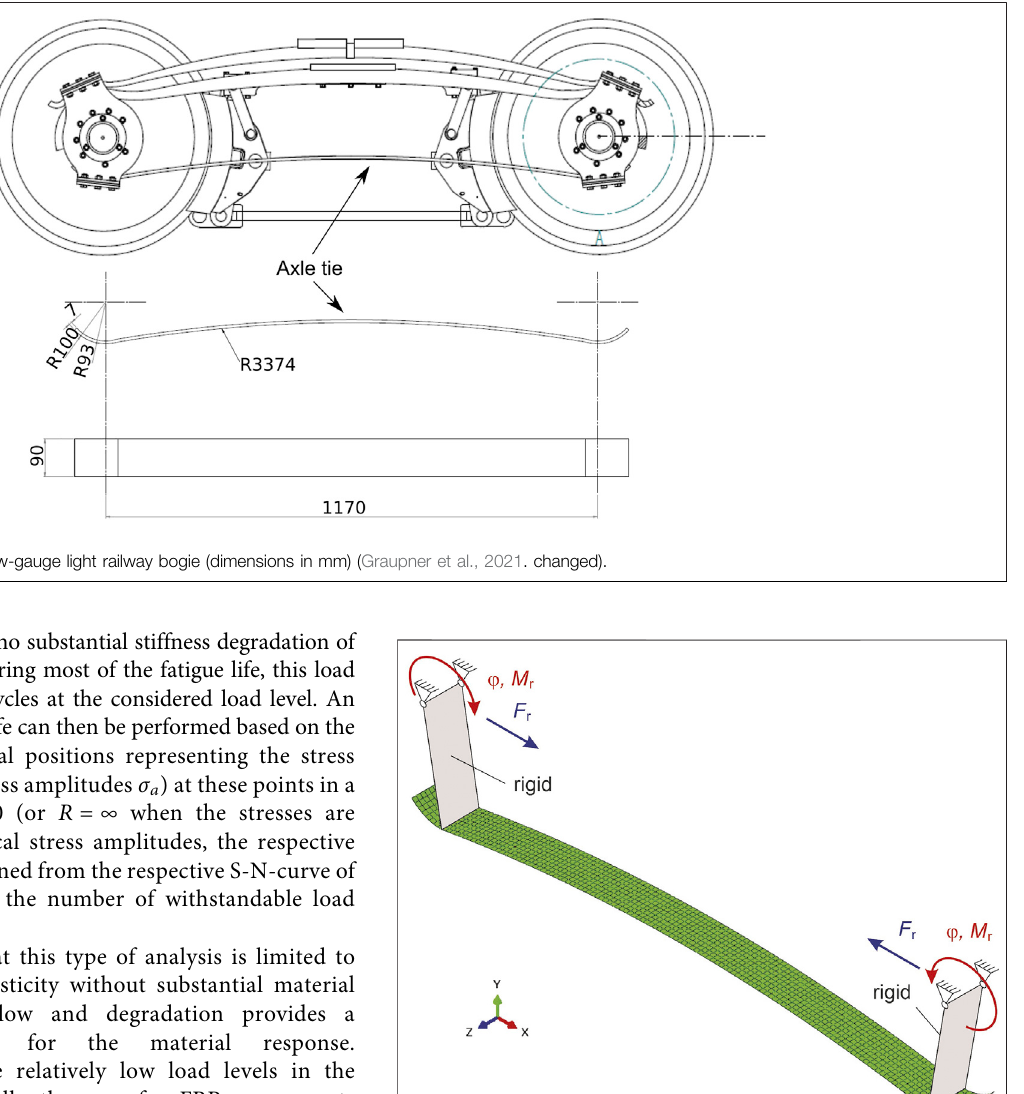
Figure 2 . Three different materials and stacking sequences were